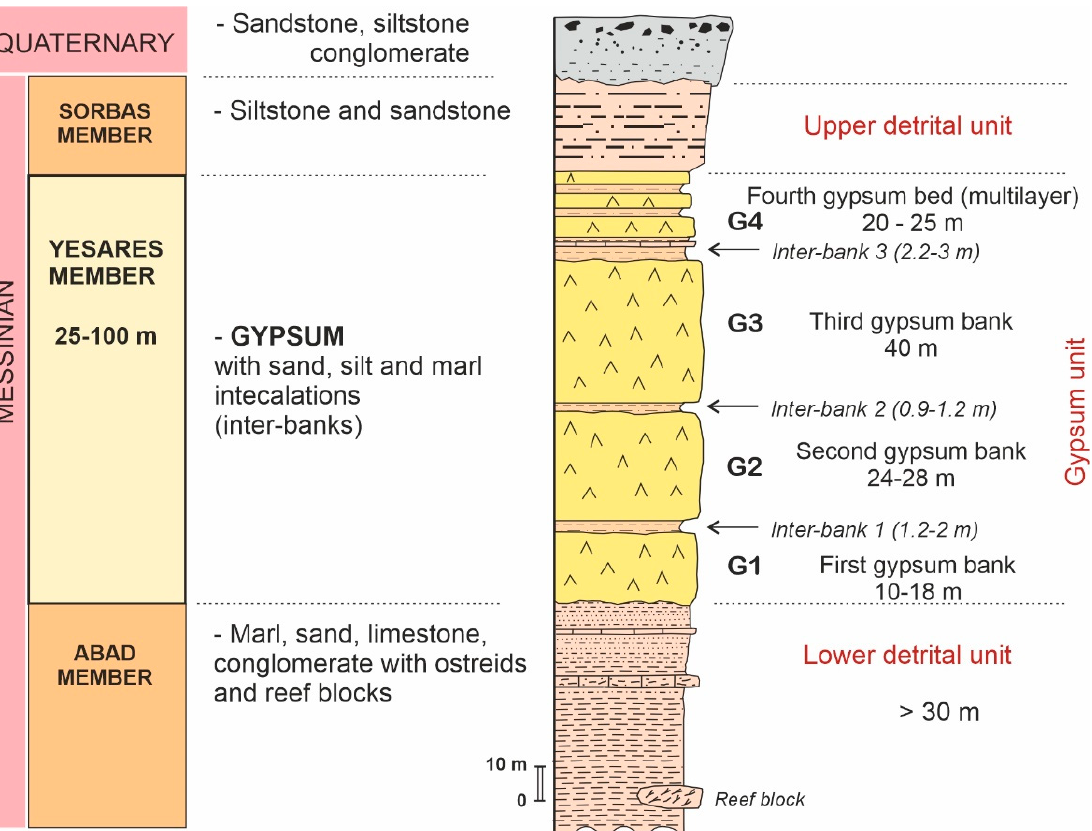
gypsum banks (G1, G2, and G3) it has been observed to have thicknesses that can vary laterally. The following thicknesses were measured for the respective banks (Figure 4): For the G1 bank between 9 and 18 m, for the G2 bank between 24 and 28 m, and for the G3 bank between 38 and 42 m. In addition, a fourth bank (G4) outcrops in the study area, which is actually a stretch of gypsum with several detrital intercalations, where each bed of gypsum does not reach more than about 4–5 m thick, although in the easternmost drillings this bank is up to 15 m thick and with fewer detrital intercalations.